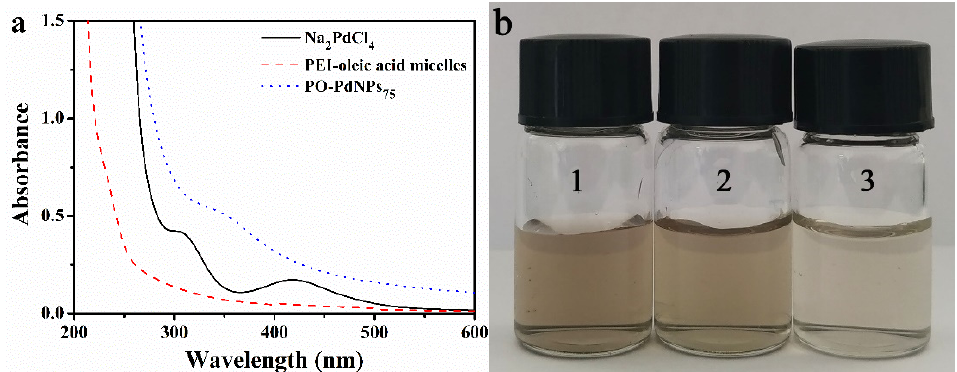
Figure 2. ( a ) UV–Vis spectra of Na 2 PdCl 4 , PEI-oleic acid micelles, and PO-PdNPs 75 , ( b ) PO-PdNPs n with molar ratio of n = [N]: [Pd] = 75 ( b1 ), 100 ( b2 ), and 150 ( b3 ), respectively.